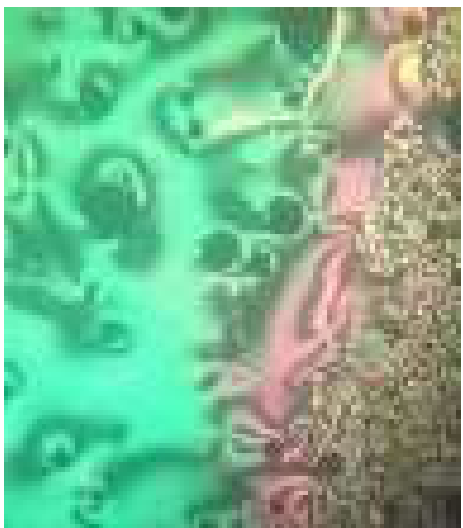
Figure 2. The POM of the N phase texture at 120.0 °C on heating of sample I10 .